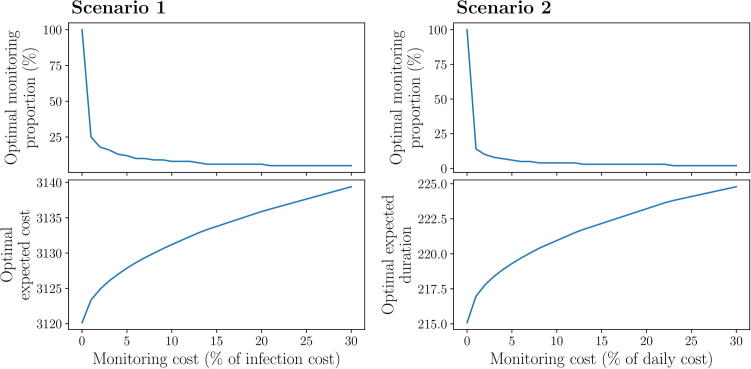
Effect of cost associated with monitoring on the optimal monitoring proportion and optimal expected cost/duration given an initial decision to vaccinate. Top row: optimal monitoring proportion given an initial decision to vaccinate for a range of monitoring costs, for scenario 1 (left) and scenario 2 (right). Bottom row: optimal expected outcome (cost or duration) given an initial decision to vaccinate for a range of monitoring costs.